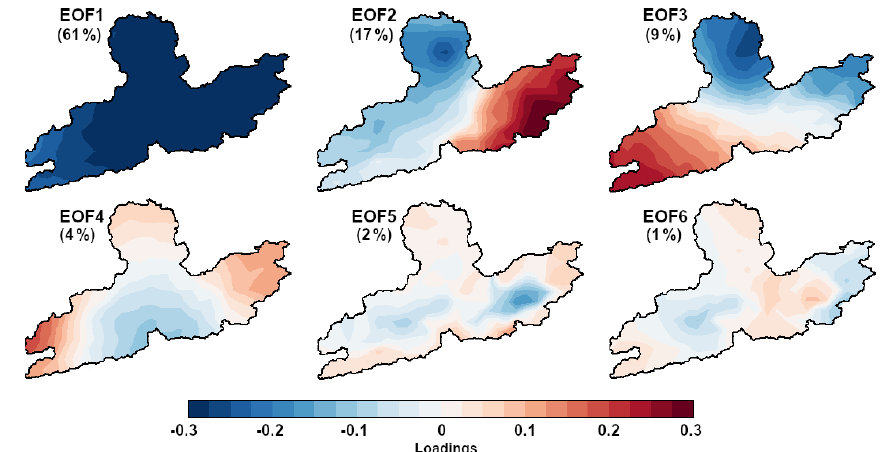
Figure 7. Six leading modes of the EOF for the months characterized by average SPEI1 values ≤− 0 . 84. The numbers between parentheses correspond to the amount of variance explained by each